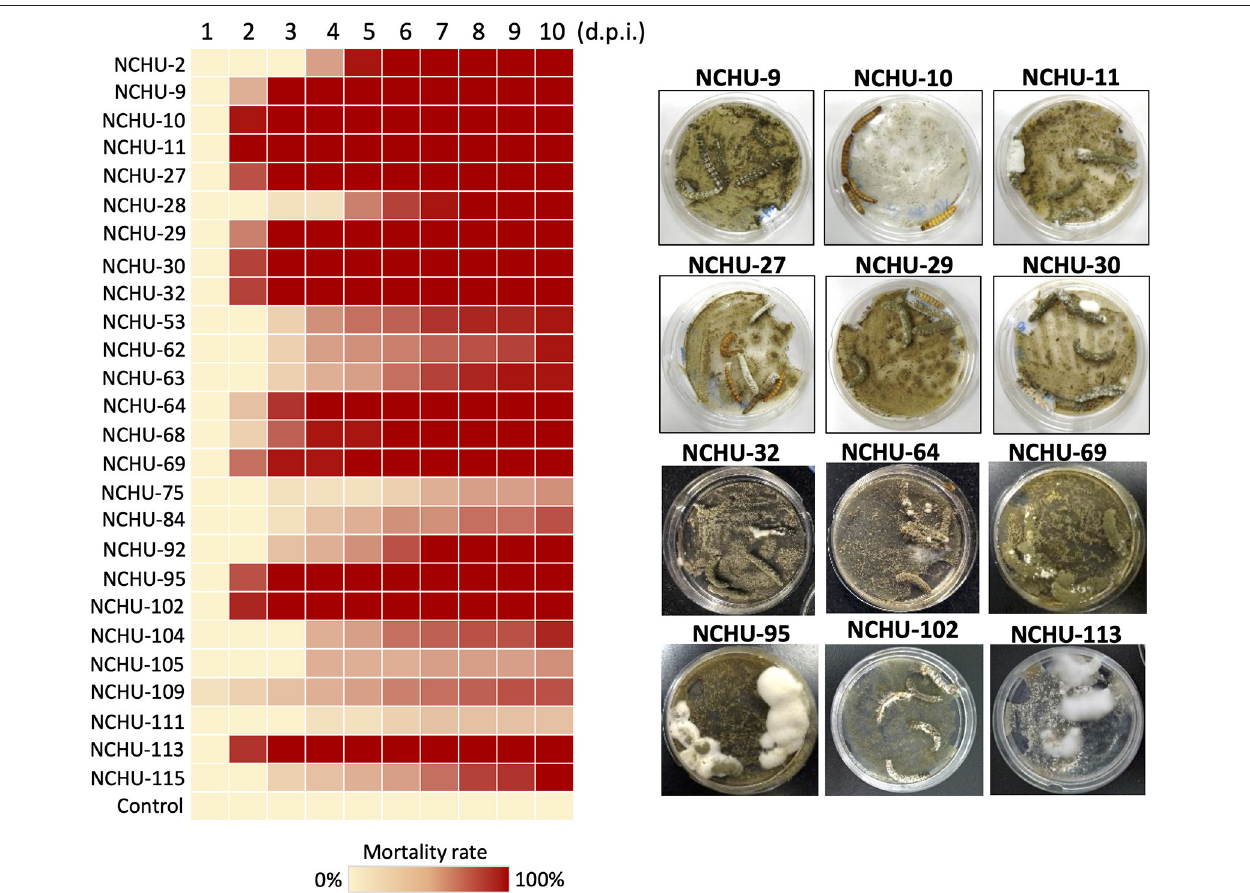
FIGURE 2 | Mortality heat map of 26 fungal isolates against mealworms. Based on the primary mealworm pathogenicity screening, 26 fungal isolates were selected based on their rapid killing and high virulence against mealworms. The mycoses of 12 rapid killing and high virulence fungal isolates are shown in parallel. Each fungal strain was repeated three times. d.p.i., days post